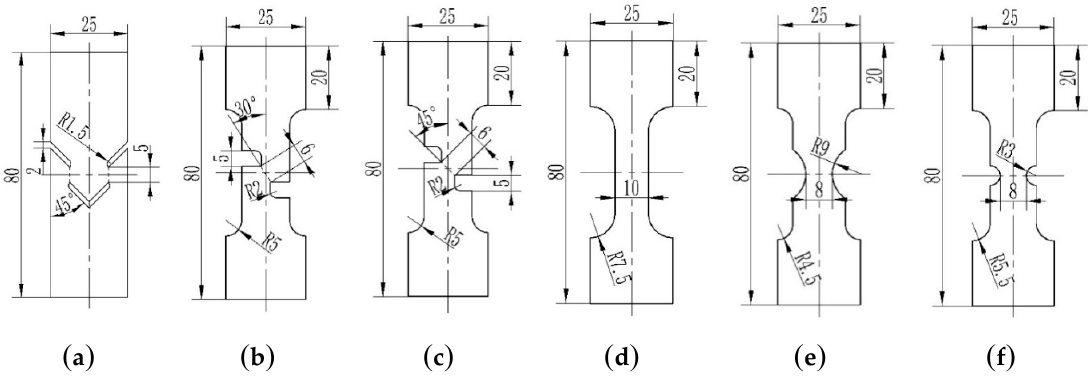
Figure 1. The geometry of five specimens (mm). ( a ) S-0; ( b ) S-30; ( c ) S-45; ( d ) DB; ( e ) NT-R9; (f) NT-